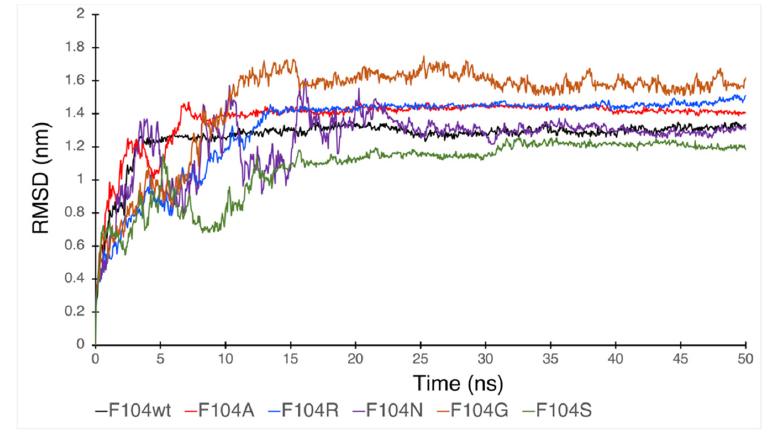
Figure 7. RMSD plot showing the effect of FAM72A mutations at wt AA F104 phenylalanine (F104 → F104A, F104R, F104N, F104G, and F104S) within the FWMF motif (AA101–104) on the dynamic nature of the FAM72A protein and UNG2 (AA1–45) peptide heterodimer binding.